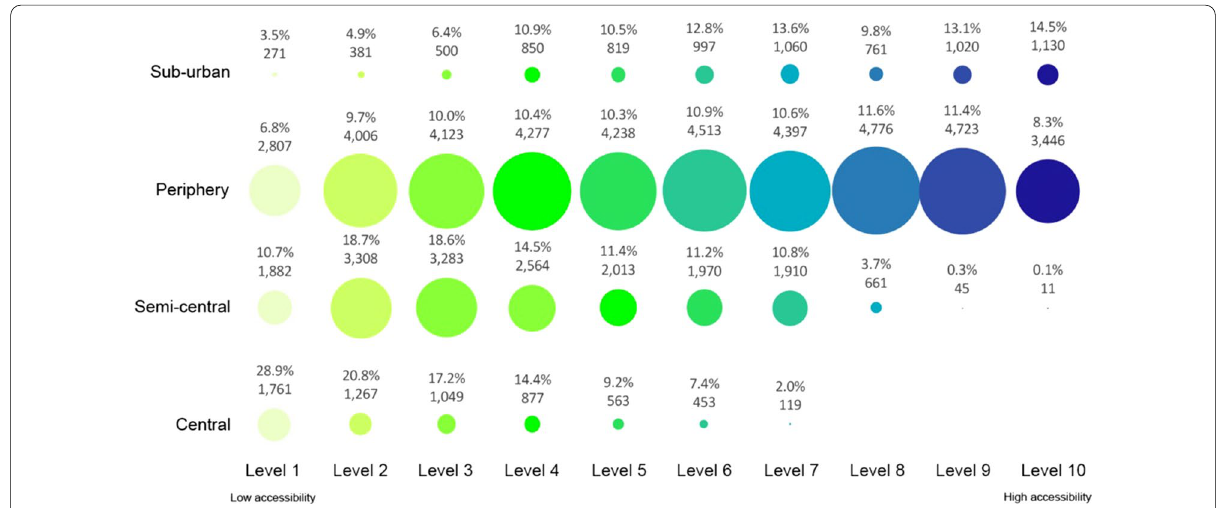
Fig. 6 Level of accessibility at the primary health centres in the Milan urban zones for elderly 65–69 years old